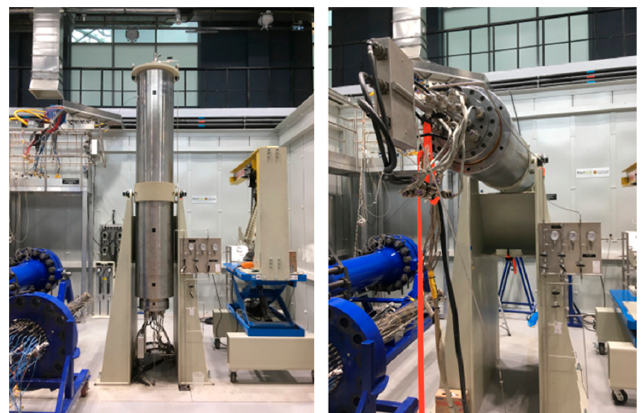
Figure 2. High-pressure combustion tube (HPCT) Equipment Images.